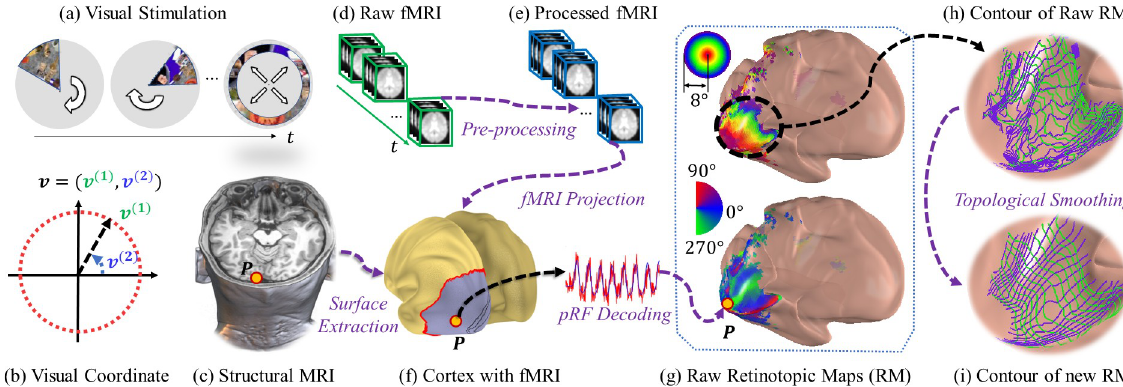
Fig 3. The processing pipelines. (A) Visual stimuli. (B) Coordinate system of the visual field. (C) Structural (anatomical) MR image. (D) BOLD fMRI scans. (E) Preprocessed fMRI signals. (F) Reconstructed cortical surface with projected fMRI activations. (G) Retinotopic maps from the pRF model. (H) Level set of the raw retinotopic maps. (I) Level set of the smoothed retinotopy